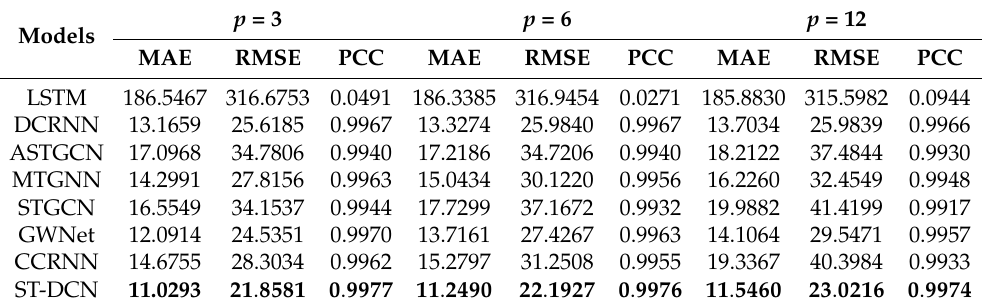
Table 2. Performance comparison of ST-DCN and other baseline models on the Chengdu Taxi dataset.